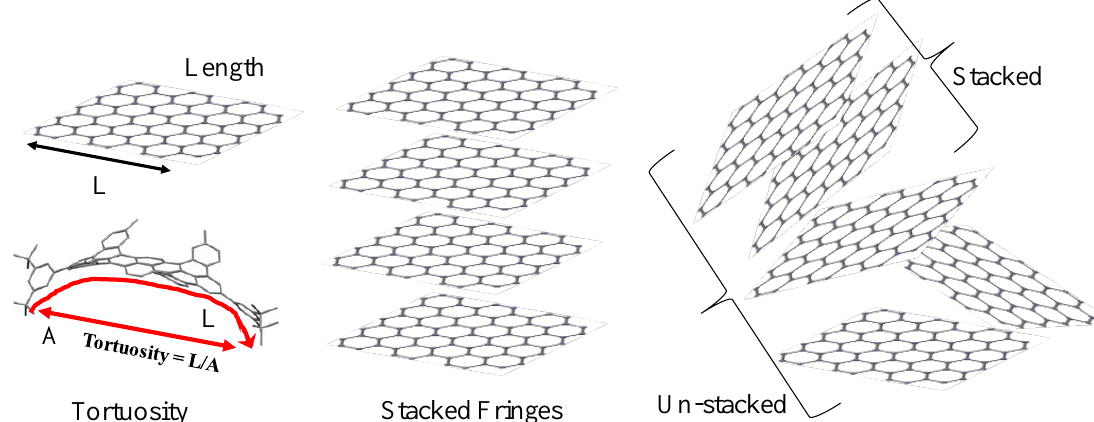
Figure 7. Fringe parameters characterizing nanostructure. C 2018 , 4 , x FOR PEER REVIEW